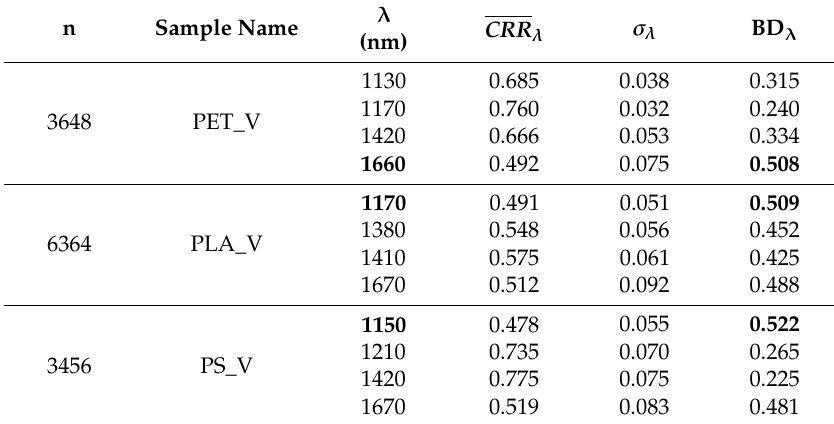
Table 2. Band Depth (BD λ ) of virgin material samples, computed from spectral signatures processed with the CR method (n is the number of spectral signatures per sample, λ the absorption band wavelength, CRR the average Continuum Removal Reflectance, σ the standard deviation, BD the Band Depth). The most evident absorption peaks are bolded. λ n Sample Name CRR (nm)